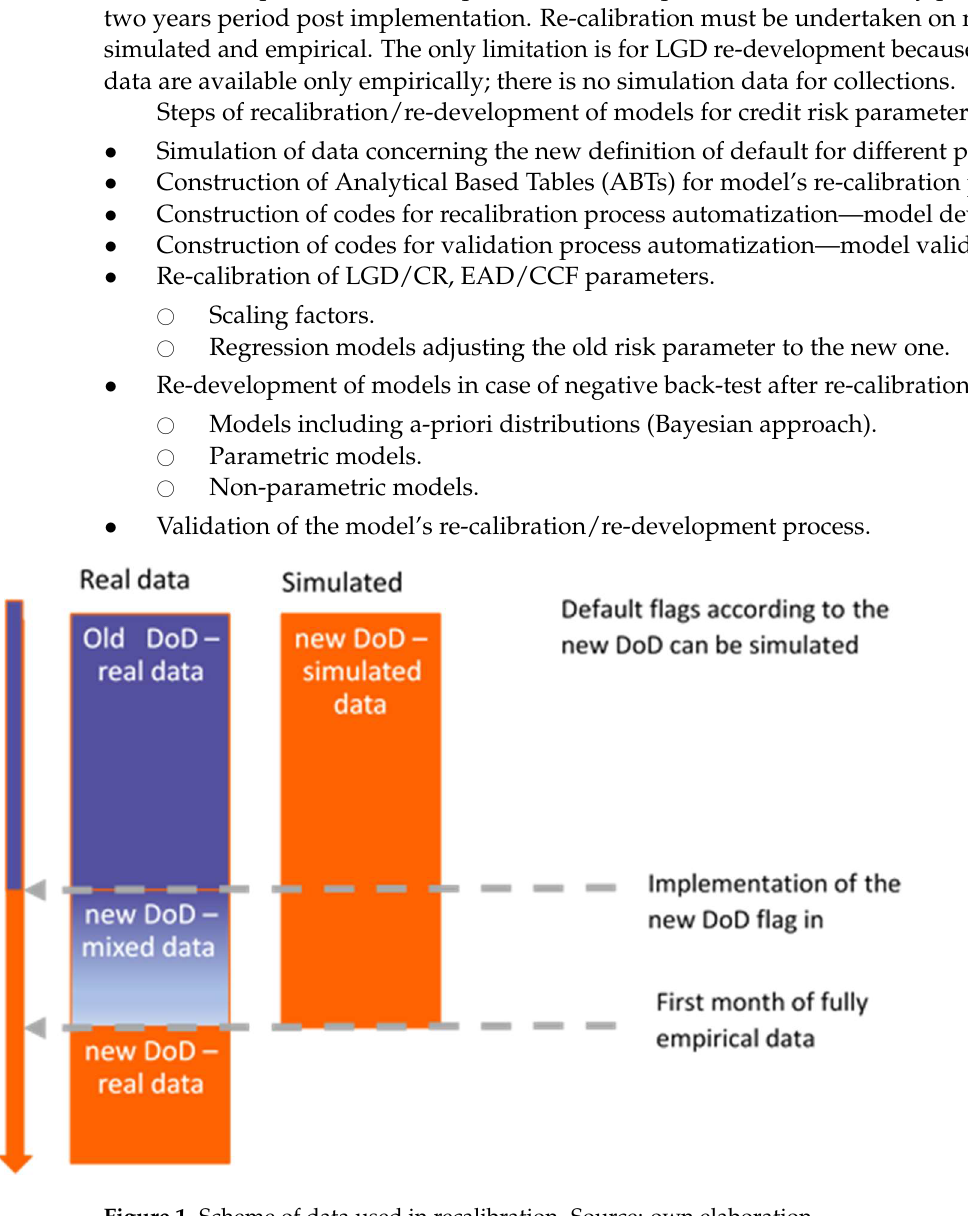
Figure 1. Scheme of data used in recalibration. Source: own elaboration. Table 1. Types of data utilized.